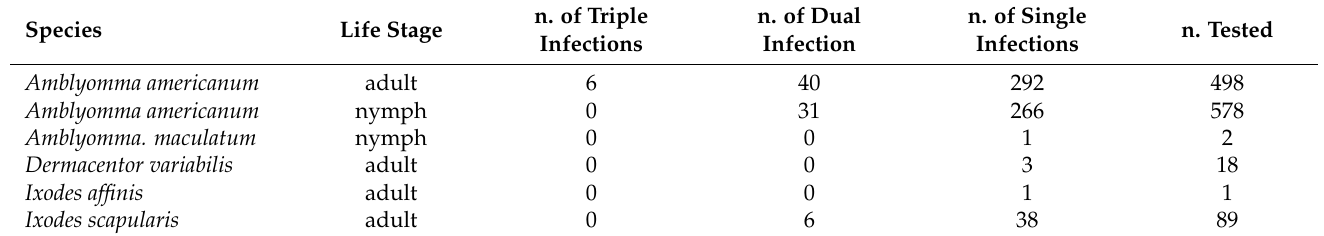
Table 4. The number of dual and triple infections in different life stages of Ixodid ticks collected in greenspaces in Alachua County, Florida,